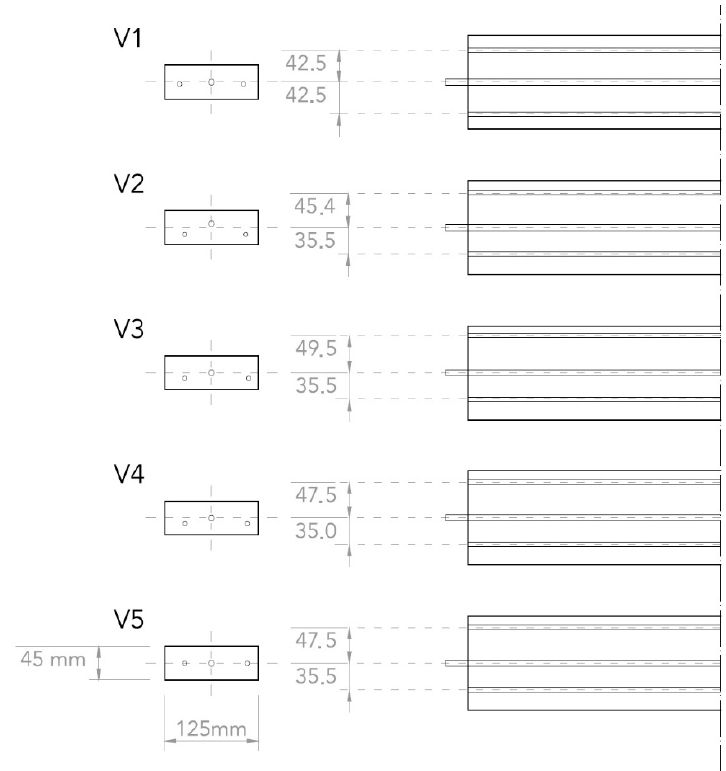
Figure 5. Tested typical RC joist specimens, provided by Forjados Orgues.